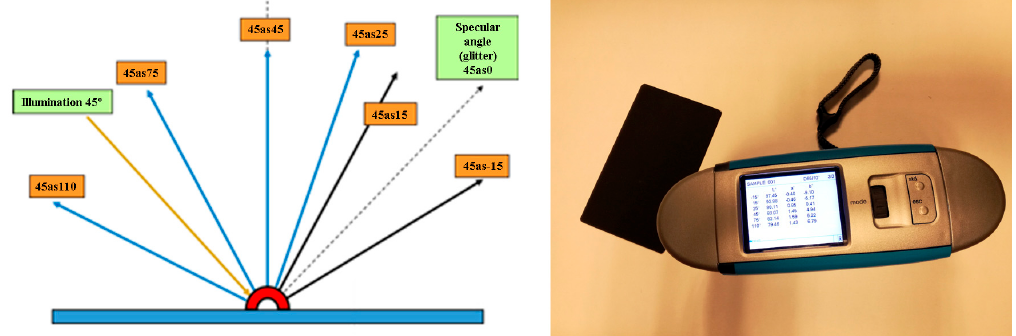
Figure 19. Measurement geometries (left) and multi-angle instrument used (right).